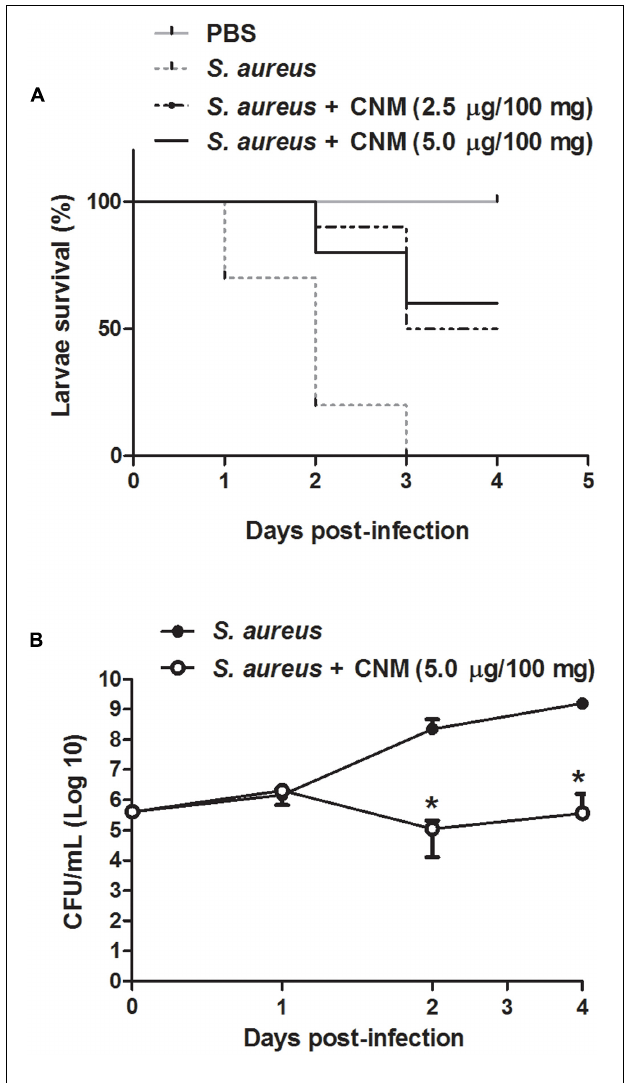
FIGURE 3 | Effect of cinnamaldehyde on survival (A) and hemolymph bacterial load (B) of Galleria mellonella larvae infected with S. aureus . G. mellonella received either cinnamaldehyde (CNM; 2.5–5.0 µ g/100 mg of larvae) or vehicle (PBS, 5 µ l/100 mg) and were evaluated for 4-days post-infection. n = 10/group for survival experiments; n = 5/group/day for bacterial load quantification. Data for bacterial load is represented as mean + SD. ∗ p < 0.05, compared with vehicle-treated larvae. Experiments were performed twice in